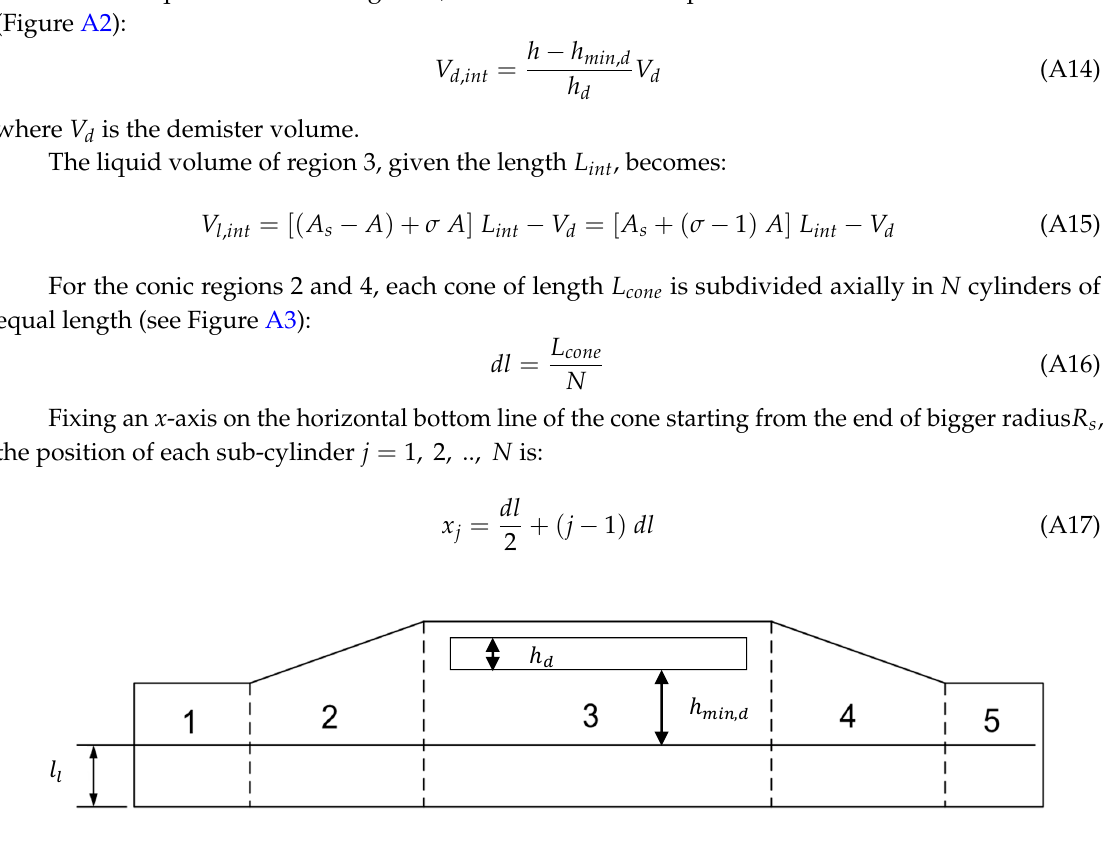
Figure A2. Discretization of the evaporator for liquid volume-level computation.